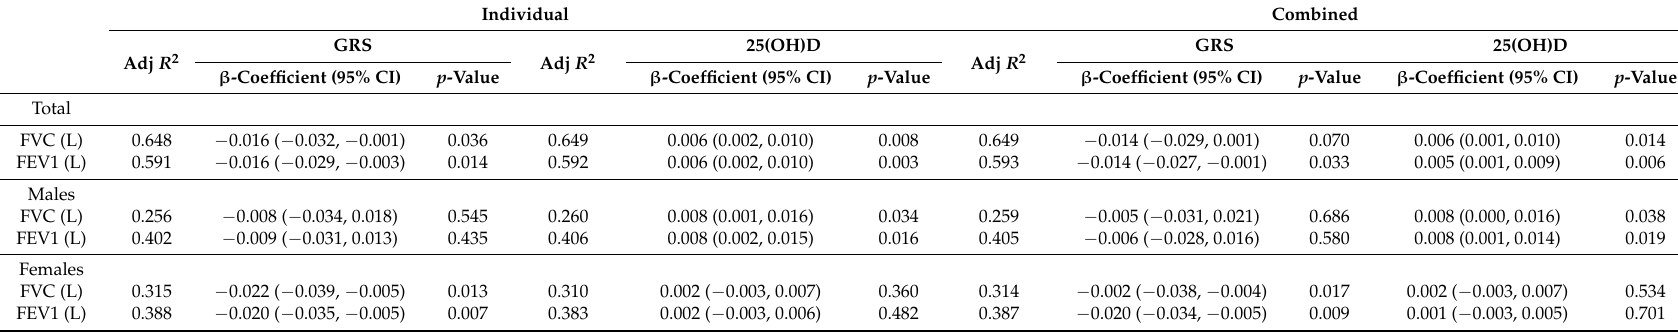
Table 4. Individual and combined effect of genetic risk score (GRS) and serum 25-hydroxyvitamin D (25(OH)D) on pulmonary function based on sex in KNHANES